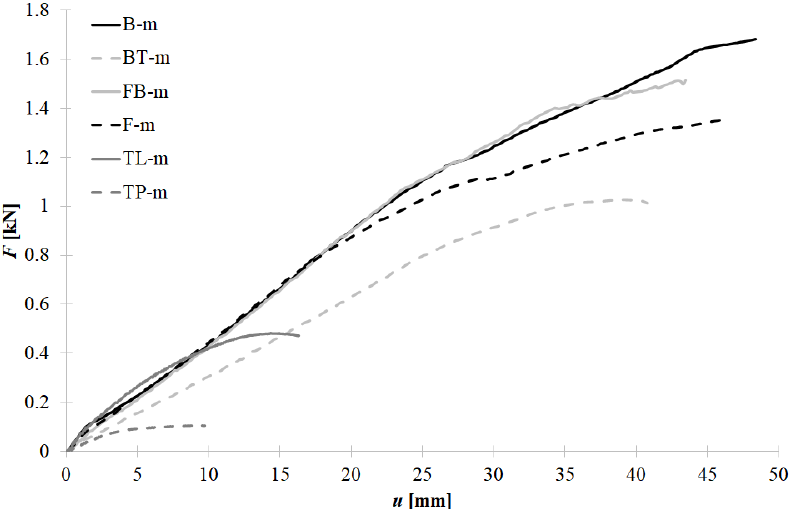
Figure 17. Mean equilibrium load ‐ displacement paths of the various method of connection between thin ‐ walled beam and sandwich panel.